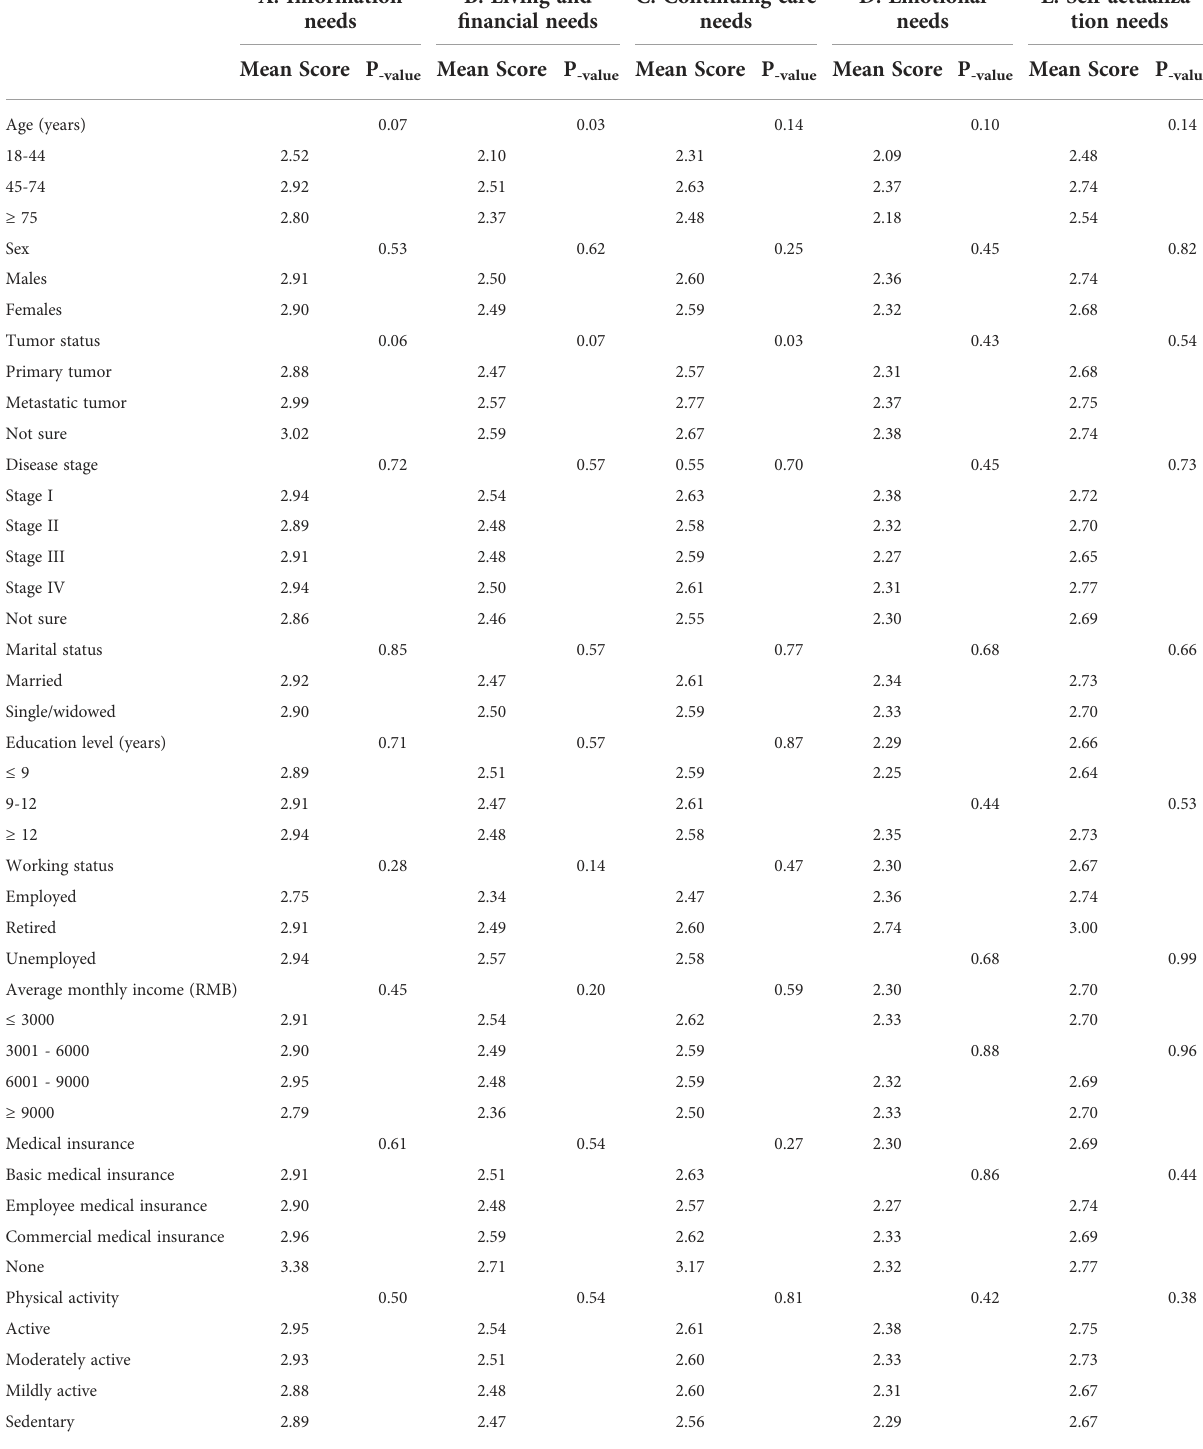
A. Information B. Living and fi nancial needs